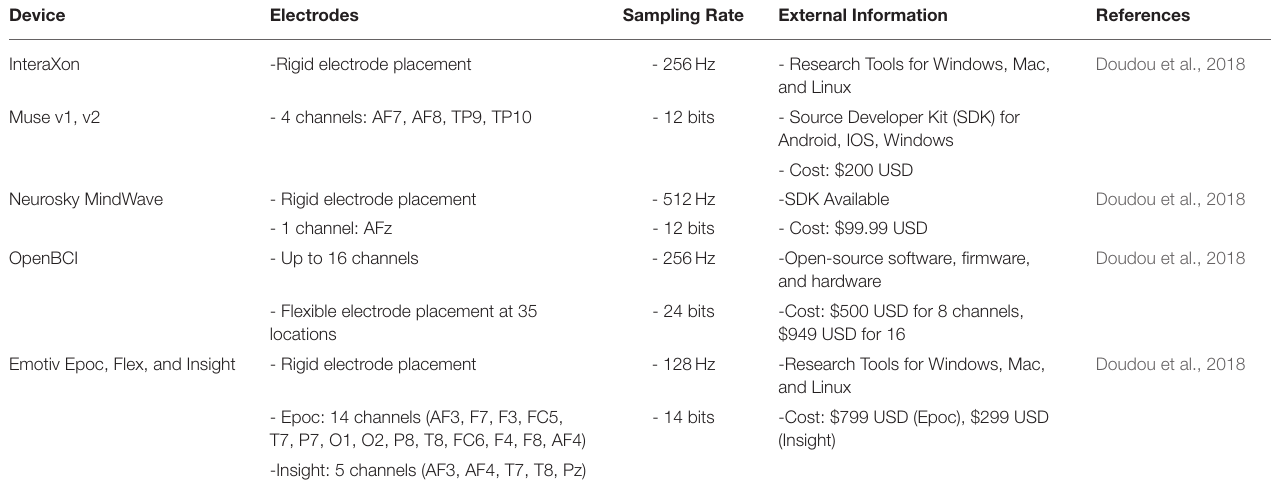
TABLE 1 | Comparison of consumer EEG